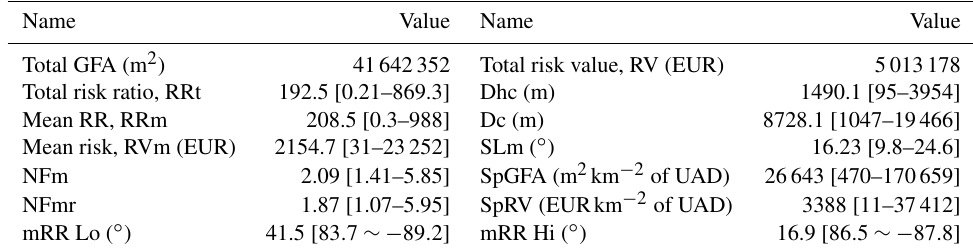
Table 6. Total values and global indicators per municipality. For indicators, means and variation